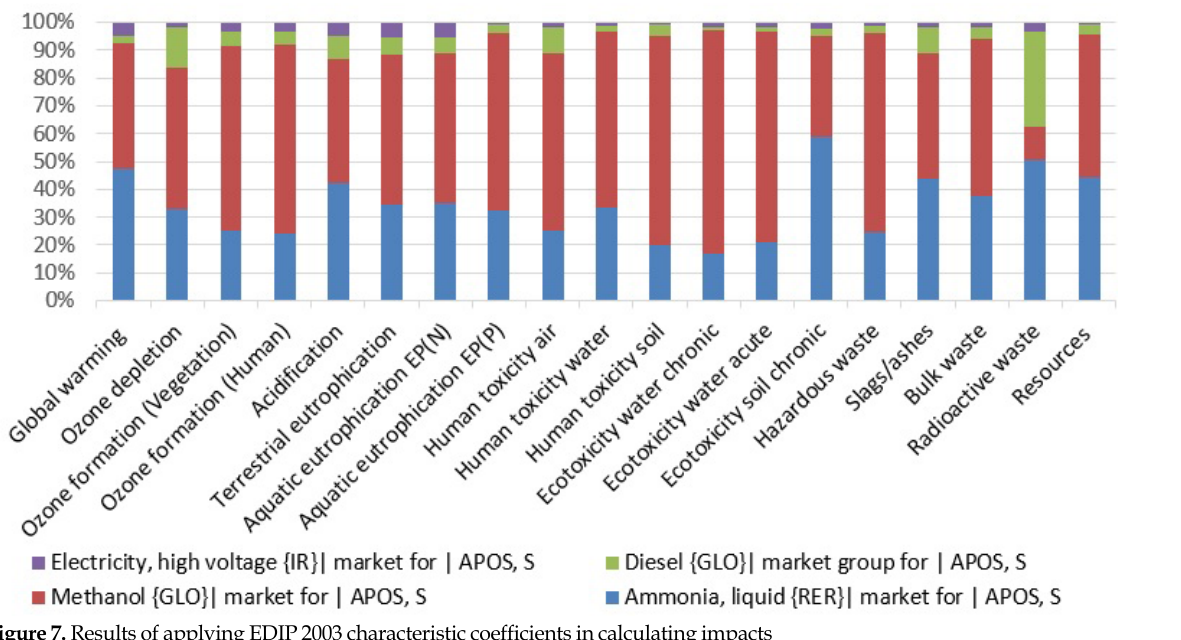
Figure 7. Results of applying EDIP 2003 characteristic coefficients in calculating impacts